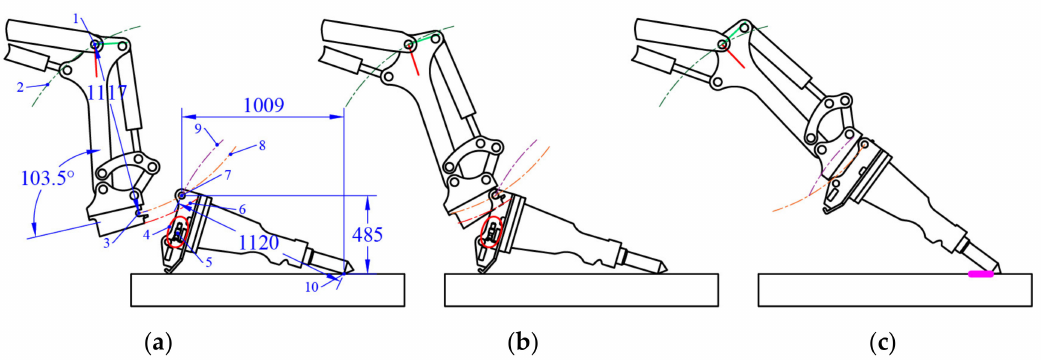
Figure 4. Trajectory of attachment changing. ( a ) Preparation: (1) joint {4}, (2) trajectory of joint {4}, (3) { W }, (4) collision region, (5) hydraulic quick coupling (male) of the attachment, (6) trajectory of quick hitch equipment edge, (7) { T }, (8) trajectory of { W }, (9) trajectory of { T }, (10) attachment support point, ( b ) range alignment, and ( c ) angle